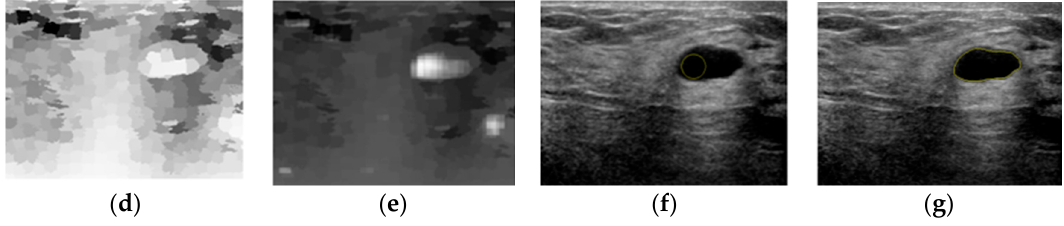
Figure 12. The localization and segmentation procedures of a US breast image. ( a ) Original image, ( b ) intensity saliency map, ( c ) blackness ratio saliency map, ( d ) superpixel saliency map, ( e ) combined saliency map of three features, ( f ) localization results, and ( g ) segmentation results by the CV level set.